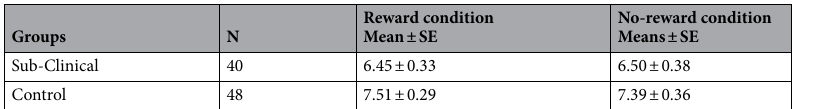
Table 2. Means and standard errors for mood scores in the reward and no reward conditions. The results of the t-test showed no significant difference in mood between groups at the baseline (t 54 ) = 1.74, p = 0.88). This table demonstrates the scores of both the groups. The sub-clinical group showed lower mood scores than the control group.